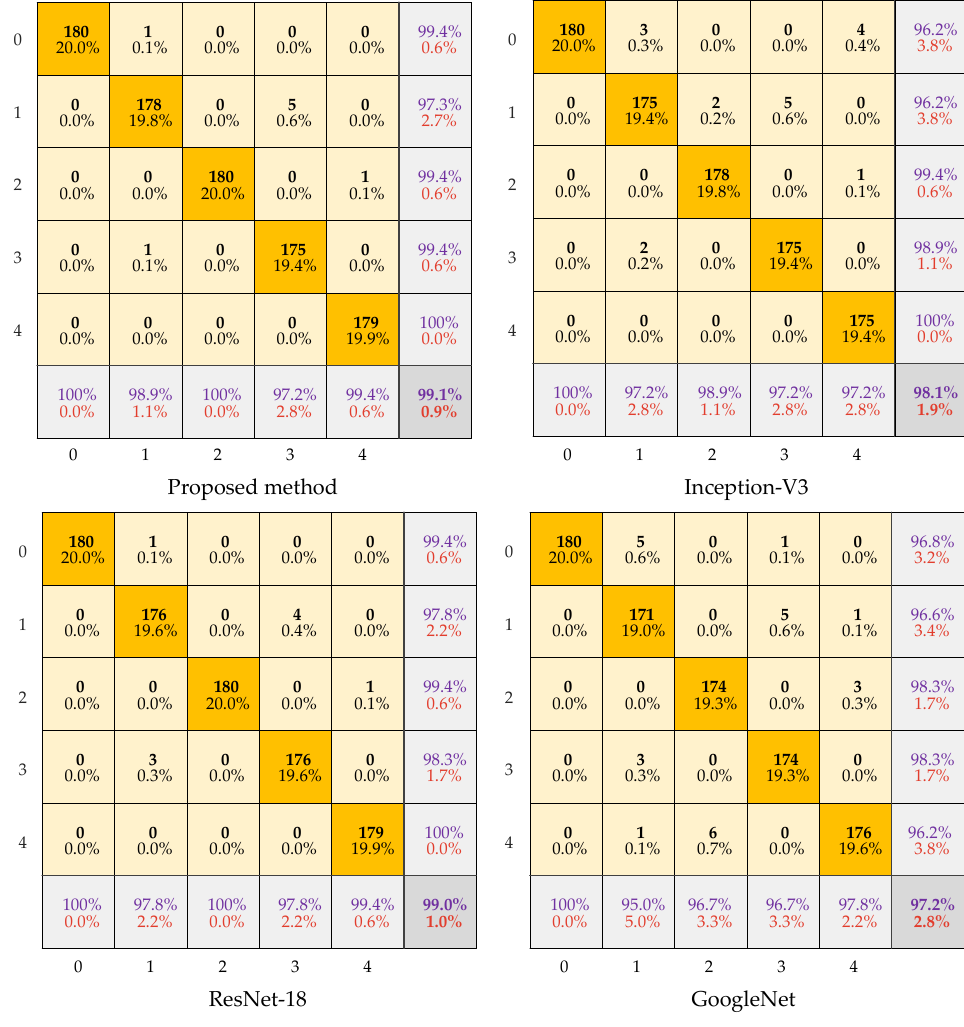
Figure 17. Confusion matrix for different methods.